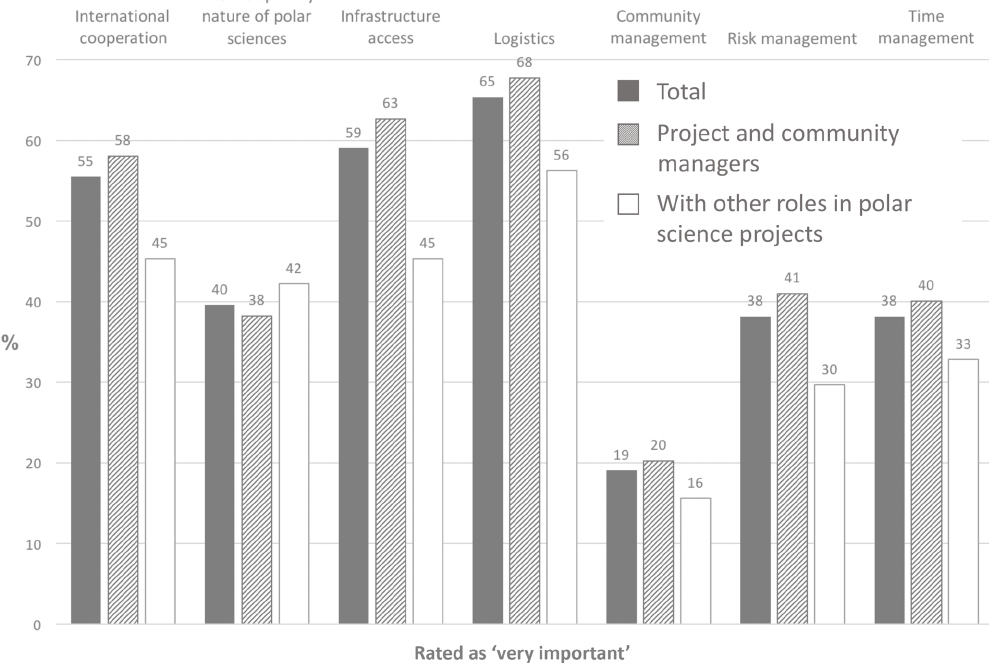
Figure 5. Important in polar science projects: Survey respondents (%) rating as “5 – very important” when asked the question Q9: Please rate (from 1 to 5) the importance of the following points for you when planning a project in polar sciences?.